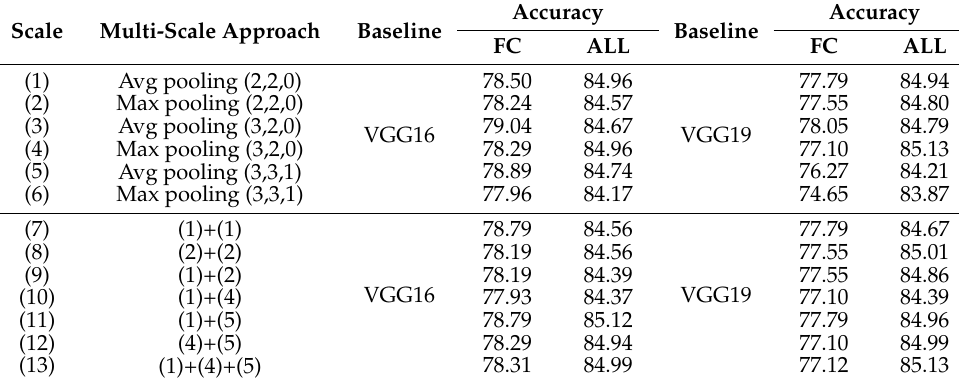
Table 1. Classification accuracy on CUB200 for MSBCNN.